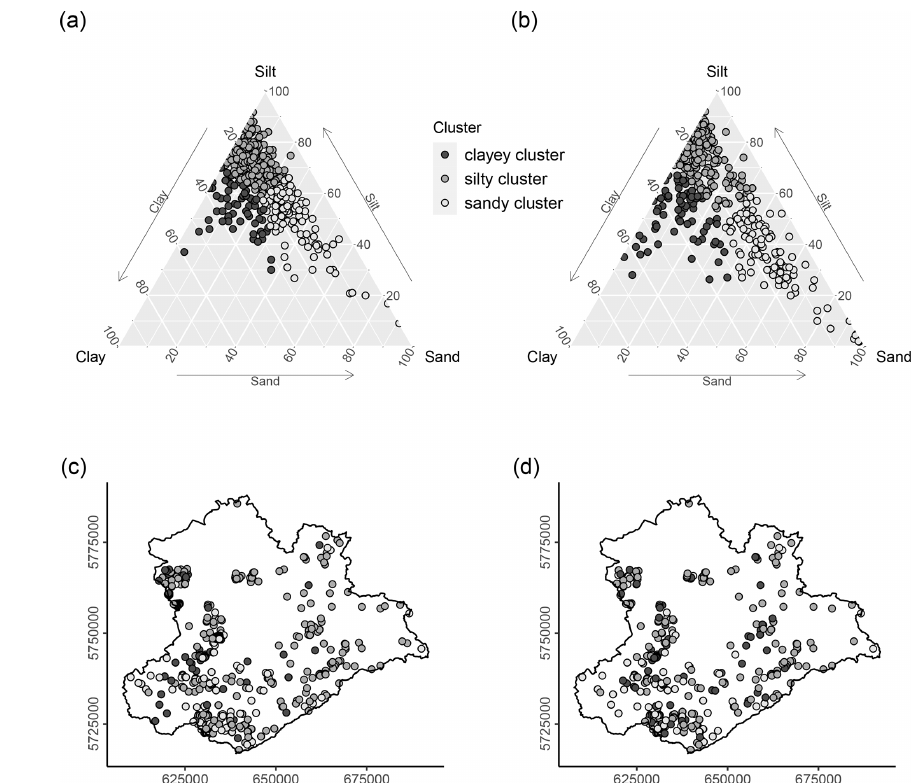
Figure 2. Soil legacy dataset used for model development. Particle size distribution and cluster affiliation of the soil data at (a) 10 and (b) 70cm depth, respectively. Panels (c) and (d) show the spatial distribution of the three clusters at 10 and 70cm depth (geographic coordinate system: UTM zone 32 ◦